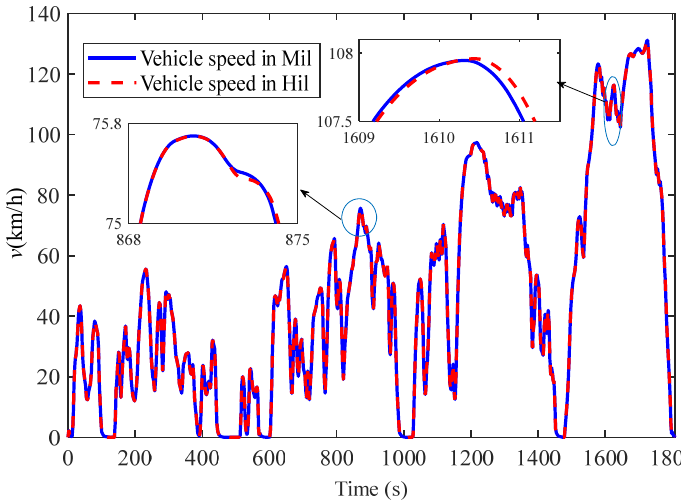
Figure 21. Speed comparison between simulation and Hil.